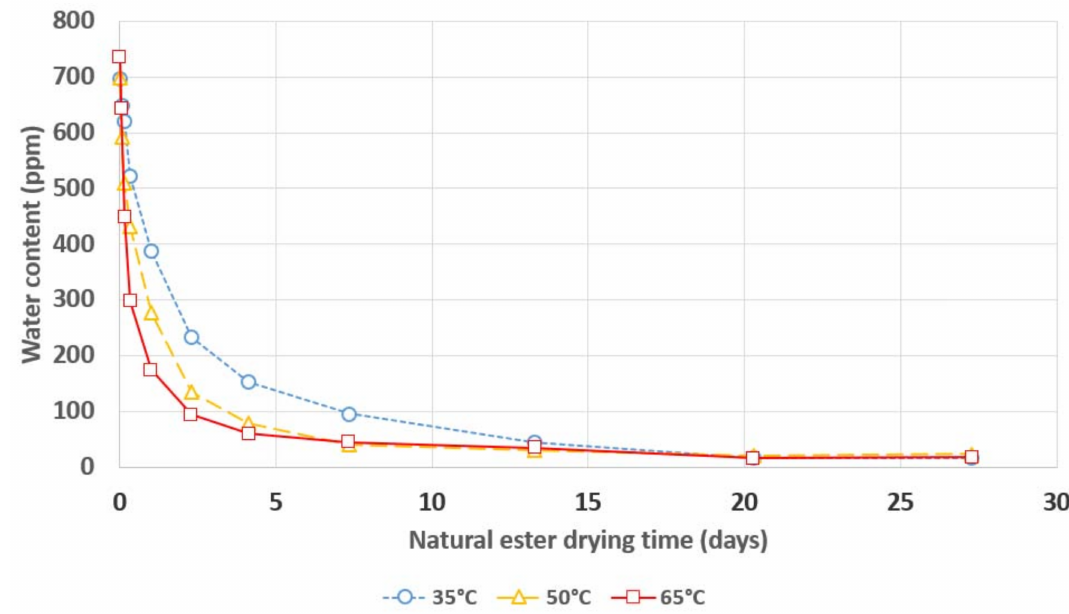
Figure 3. Water content in natural ester during its drying with a 3A molecular sieve.